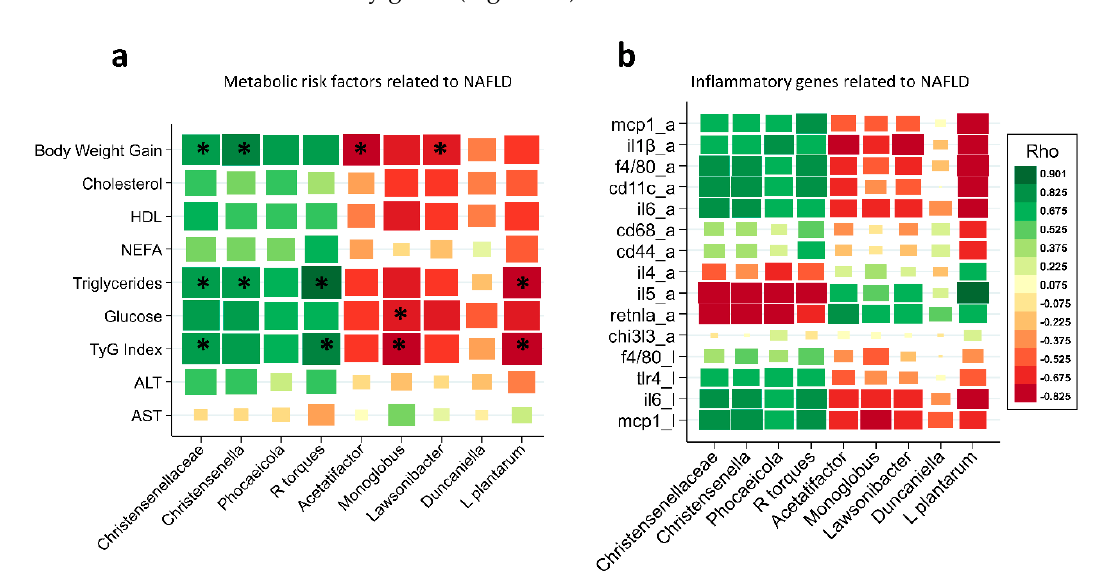
Figure 7. Correlation of gut microbiota changes with underlying factors related to NAFLD: ( a ) metabolic risk factors related to NAFLD; ( b ) inflammatory genes related to NAFLD; “a” in adipose tissue: “l” in liver. Spearman correlation coefficients (Rho) and the corresponding p -values were calculated on the basis of comparisons of the relative abundance from species, genera, and families, as well as the underlying factors related to NAFLD. The green colour indicates a positive correlation coefficient, and the red colour represents a negative coefficient (* FDR p < 0.05) .